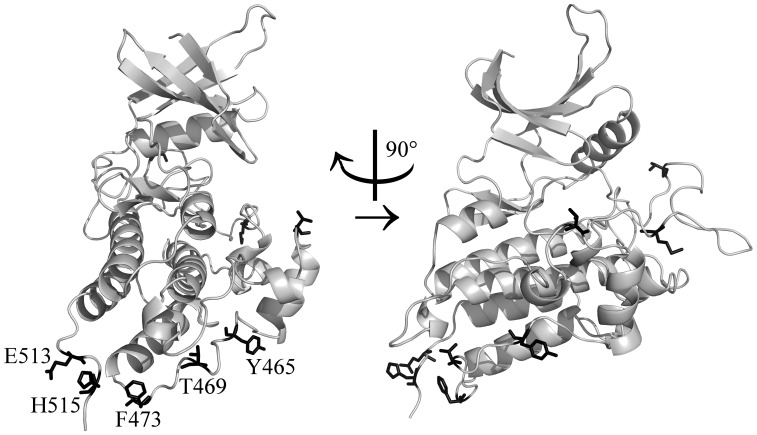
AMHR2 kinase domain mapped onto experimental structure of BMPR2 kinase domain.All eight longevity-selected positions found in this domain are shown as black sticks and are further described in Table S2. The five longevity-selected positions discussed in the text are labeled; they are found on the αG–αH loop (Y465, T469, and F473) and the C-terminal loop following αI (E513 and H515).